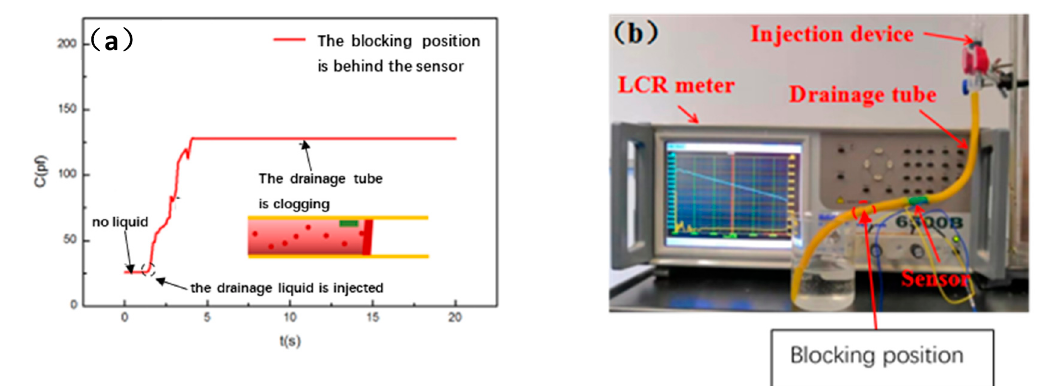
Figure 8. ( a ) Capacitance change curve of the sensor where the drainage tube is blocked and the blocking position is behind the sensor. ( b ) Photo of blockage position in simulation experiment.